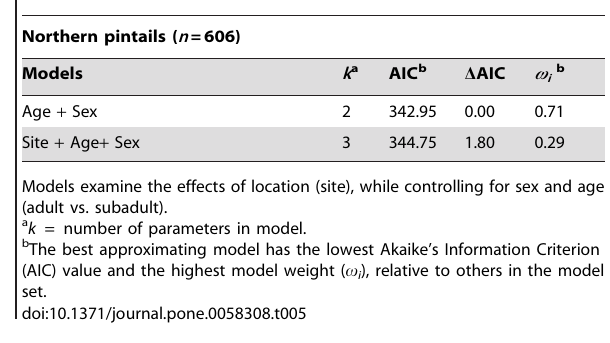
Table 5. Logistic regression models of variation in avian influenza virus (AIV) seroprevalence for northern